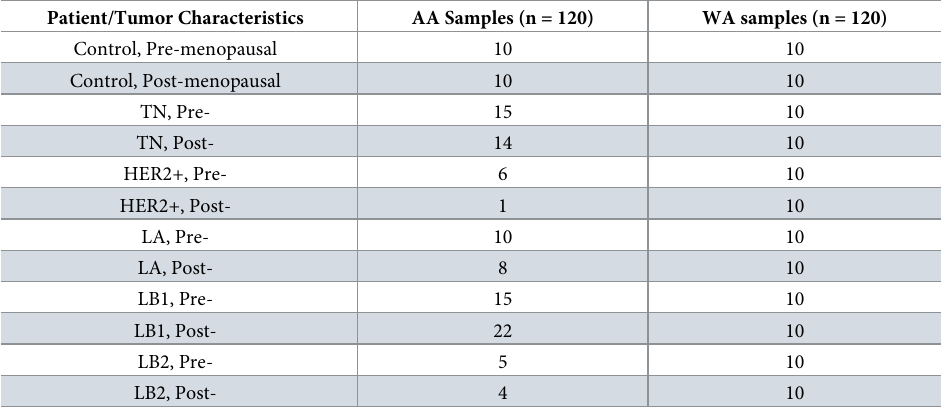
The Table breaks down samples into various patients with tumor sub-types characteristics. Abbreviation used: AA-African American, WA-White American, TN, triple-negative subtype; Her2, human epidermal growth factor receptor 2 subtype; LA, Luminal A subtype; LB1, Luminal B1 subtype; LB2, Luminal B2